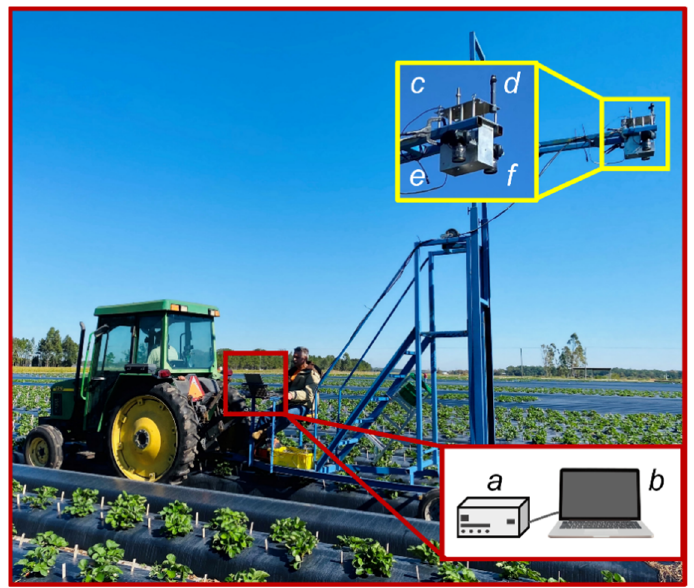
Figure 3. Ground-based imaging platform pulled by a tractor carrying ( a ) camera trigger box hardware; ( b ) computer; ( c ) timing GPS; ( d ) GNSS navigation system; ( e ) Nikon D300 RGB camera and ( f ) Nikon D300 NIR camera.